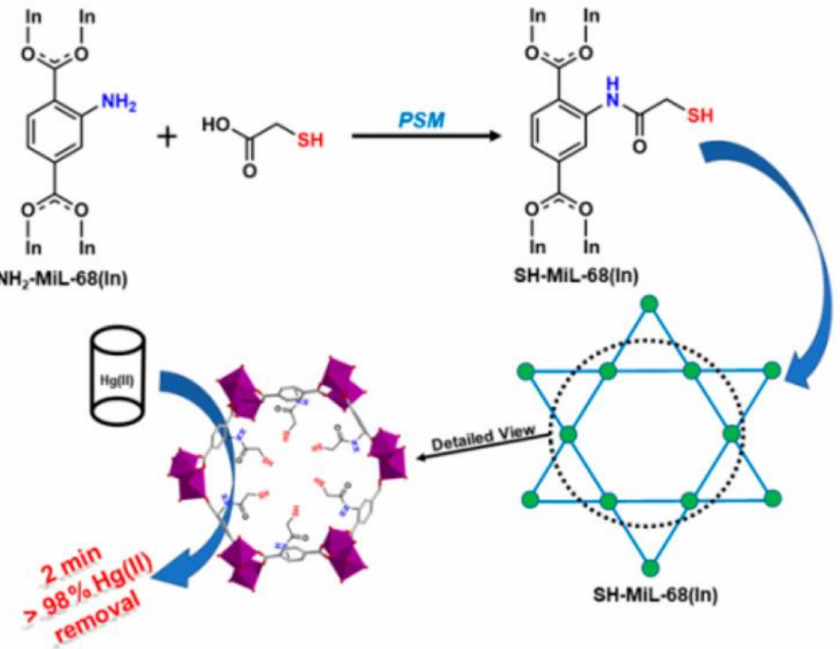
Figure 11. Schematic of post-synthetic modification of NH 2 -MIL-68(In) to afford SH-MIL-68(In) and its utilization in Hg 2+ extraction (Reproduced with the permission from Ref